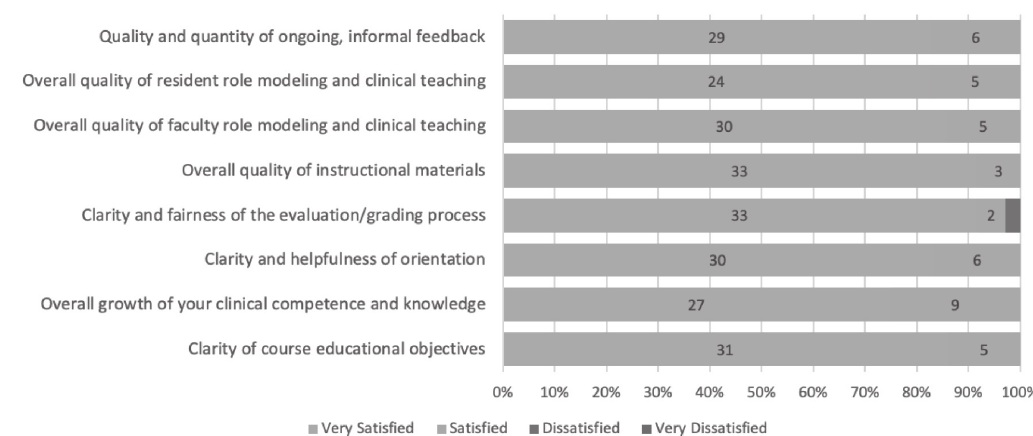
Figure 1. Post-course survey responses related to student satisfaction in various instructional categories